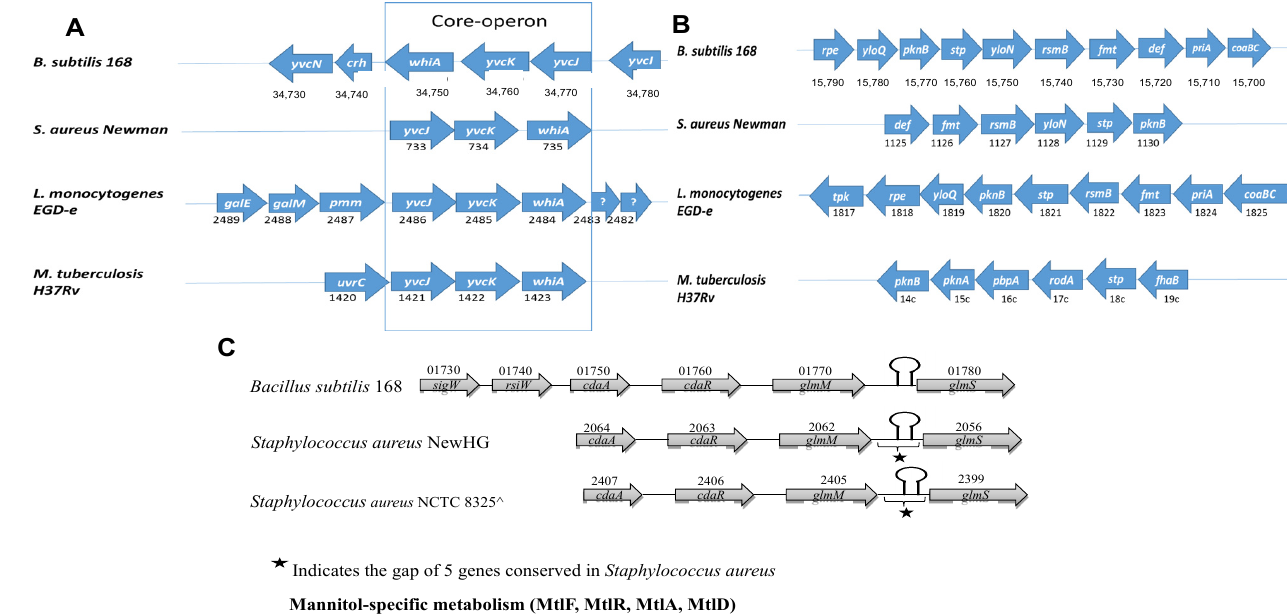
Figure 7. Comparison of regulatory operons in different organisms. ( A ) The glmR/yvcK operon composition in B. subtilis, S. aureus, L. monocytogenes and M. tuberculosis . Three consecutive genes whiA, yvcK and yvcJ are conserved in all the four organisms, which are core genes. Others are accessory genes located either upstream or downstream of the core gene cassette. Arrows indicate the gene sequence strand, and numbers at the bottom are the locus tag numbers, which are generally the sequential order in the genome. A detailed evaluation of the observed conservation is given in Figure S5. ( B ) The pknB operon composition in B. subtilis , S. aureus , L. monocytogenes and M. tuberculosis . Arrows indicate the gene size and the sequence strand, and numbers at the bottom are the locus tag values, which are generally the same as the sequential order in the genome. The genes of the pknB operon appear to be variable in different organisms, B. subtilis , S. aureus and L. monocytogenes are similar in the core composition of the pknB operon, whereas M. tuberculosis is relatively distinct. ( C ) Comparison of the cdaA - cdaR - glmM - glmS operon structure. Compared are the operons from Bacillus subtilis 168 and S. aureus NewHG and NCTC 8325 (both strains) including the glmS ribozyme. Four mannitol-specific transporters, enzymes (MtlF, MtlR, MtlA, MtlD) and a methicillin-resistance determinant protein (FmtB) are specific for the S. aureus cdaA operon, and the genes are located between glmM and glmS . The loop indicates the glmS riboswitch.